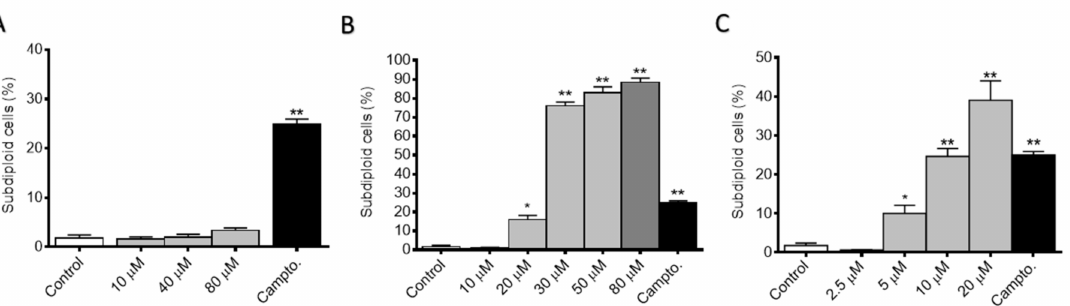
Figure 4. Percentage of subdiploid cells in MCF-7 cultures after 24 h of treatment with increasing doses of I.1f ( A ), I.2f ( B ) or II.2d ( C ). * Statistical significance with values of p < 0.05; ** statistical significance with values of p < 0.01.